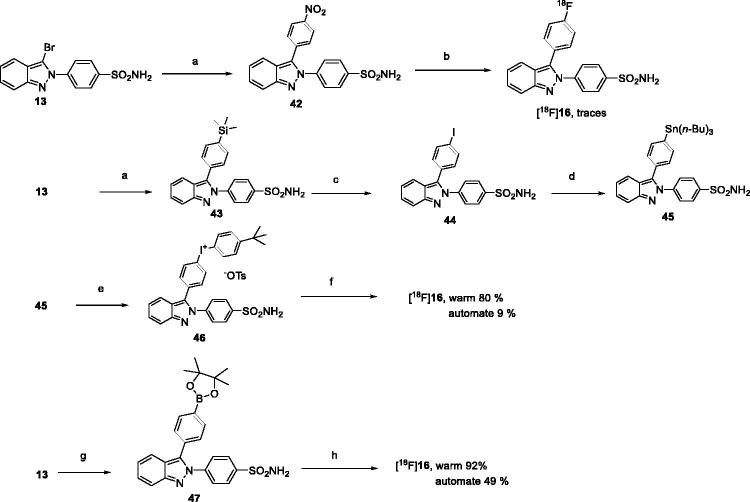
Methods for radiolabeling. Reagents and conditions: (a) corresponding boronic acid (1.2 equiv), Cs2CO3 (3.0 equiv), Pd(PPh3)4 (0.1 equiv), dioxane, 150 °C, μW, 1 h, 42 53%, 43 69%; (b) [K/K222]+18F–, DMF, 130 °C, μW, 20 min; (c) ICl (2.0 equiv), CH2Cl2, 0 °C then t.a., 1.5 h, 99%; (d) n-Bu6Sn2 (3.3 equiv), Pd(PPh3)4 (0.1 equiv), dioxane, 90 °C, 2 h, 33%; (e) Moser reagent (1.5 equiv), CH3CN/CH2Cl2 (1/1), r.t., 18 h, 73%; (f) [K/K222]+ 18F–, DMF, Cu(OTf)2 cat, 100 °C, μW, 10 min; (g) 1,4-bis(4,4,5,5-tetramethyl-1,3,2-dioxaborolan-2-yl)benzene (3.0 equiv), Na2CO3 (6.5 equiv.), Pd(PPh3)4 (0.02 equiv), dioxane, 100 °C, μW, 40 min, 52%; (h) KOTf; K2CO3, [18F]KF, Cu(OTf)2 cat., DMF, pyridine, 130 °C, 20 min.